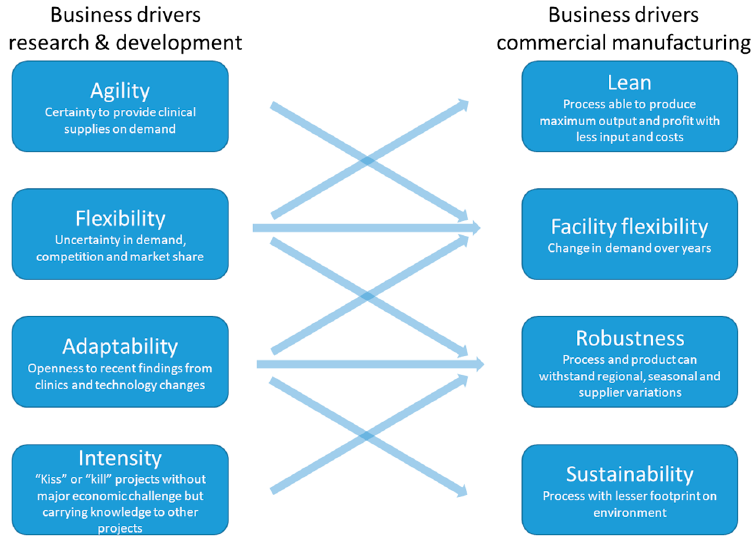
Figure 4. Alignment between interlinked business drivers in industrial research and development (R&D) unit and commercial manufacturing is key to success.